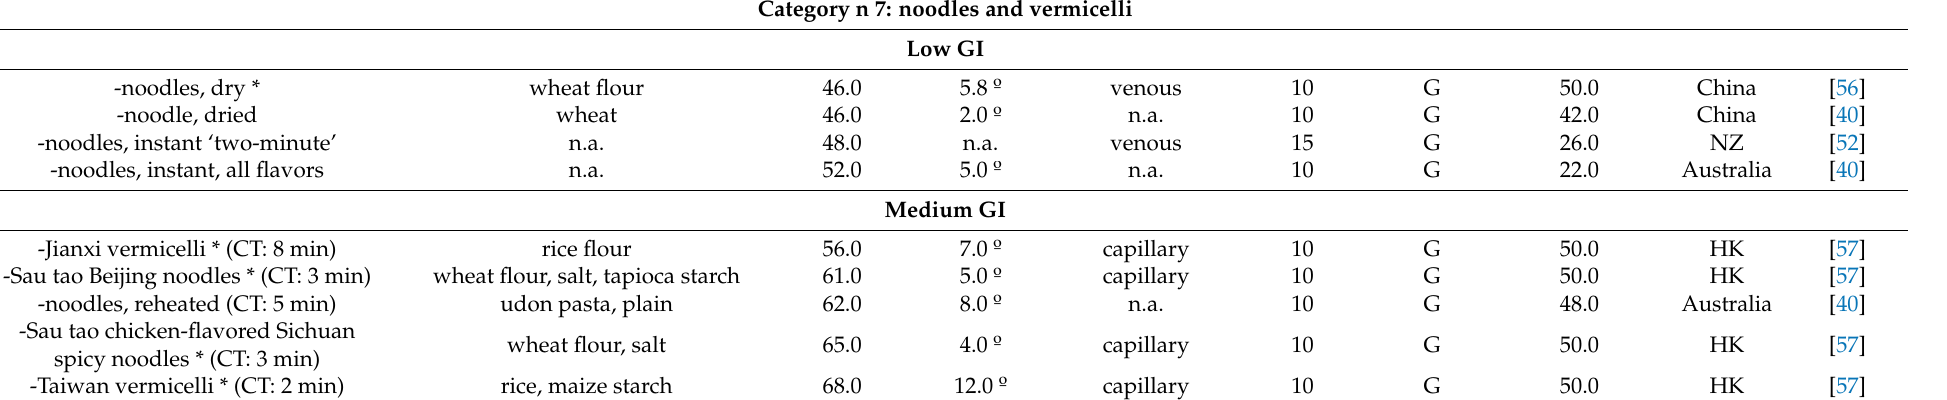
Table 1. Pasta product characteristics, glycemic index and experimental protocol data.